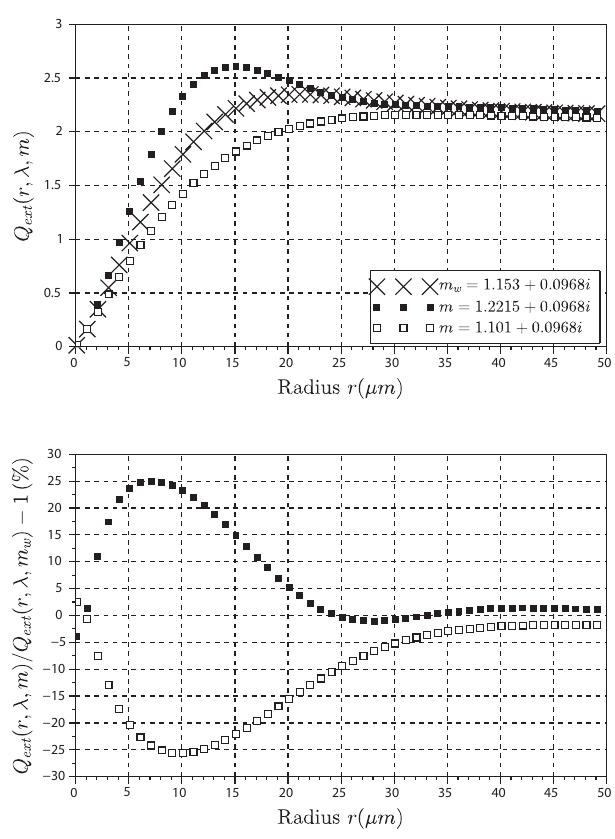
Fig. 12. As Fig. 10, for varying real parts of the fog droplet refrac- tive index.